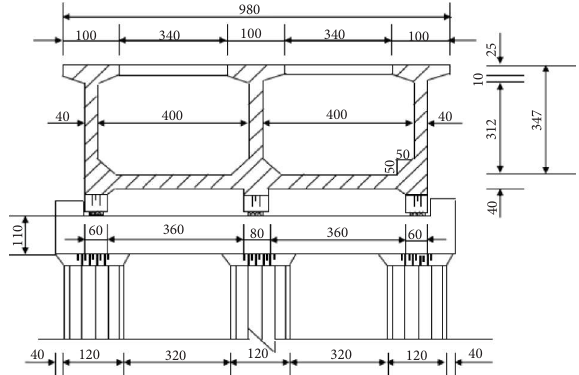
Figure 7: Column fber beam element